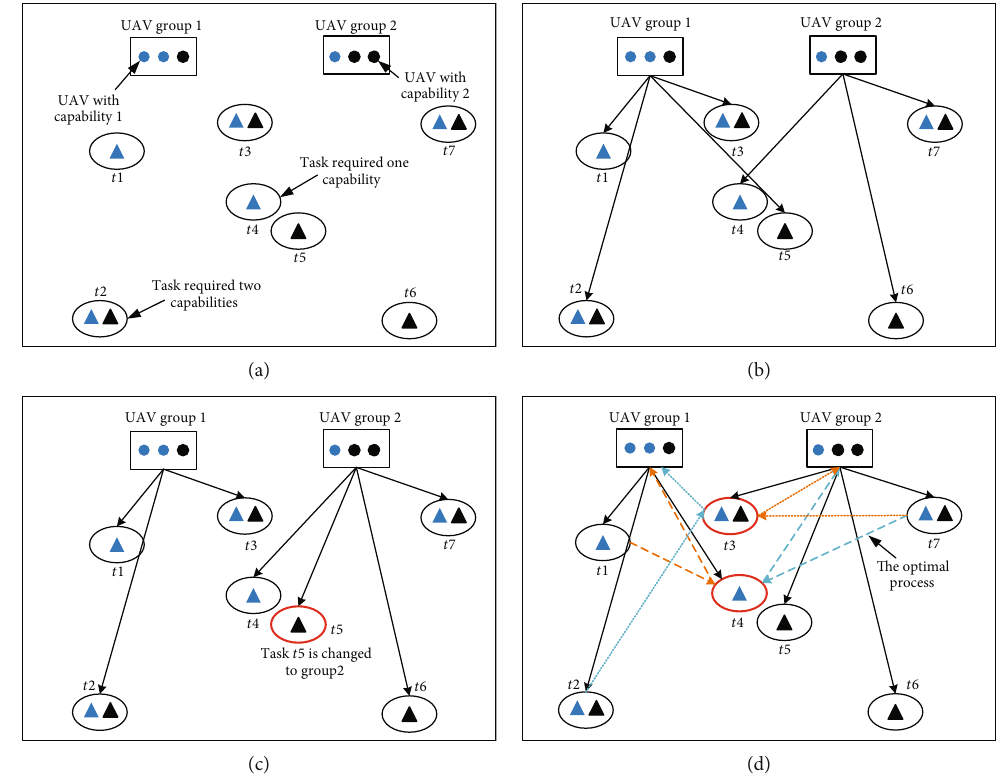
Figure 6: An example of the task assignment process between UAV groups based on DP: (a) the initial situation; (b) random assignment; (c) the optimal process; (d) the fi nal